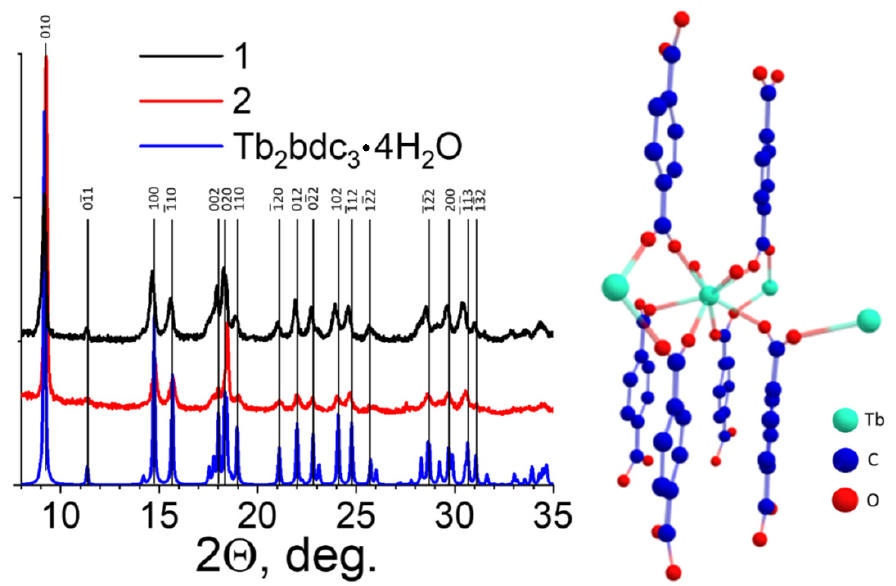
Figure 4. The XRD patterns of europium(III) terephthalate powders ( 1 and 2 ) and the simulated XRD pattern of Tb 2 bdc 3 · 4H 2 O single-crystal structure taken from ref. [32] and the crystal structure of Tb 2 bdc 3 · 4H 2 O. Table 2. Unit cell parameters for Tb 2 bdc 3 · 4H 2 O [32] and Eu 2 bdc 3 · 4H 2 O (Samples 1 and 2 ).